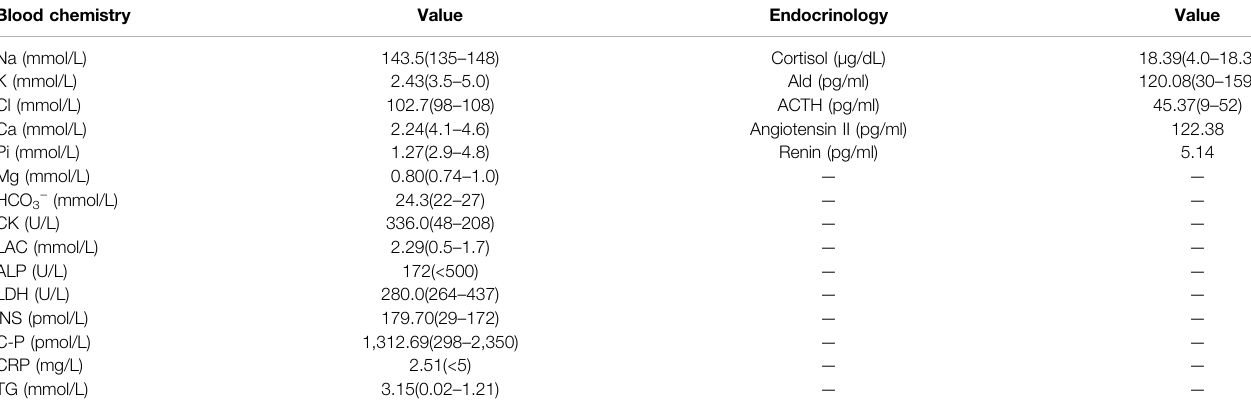
TABLE 1 | Laboratory data on the fi rst admission. Blood chemistry